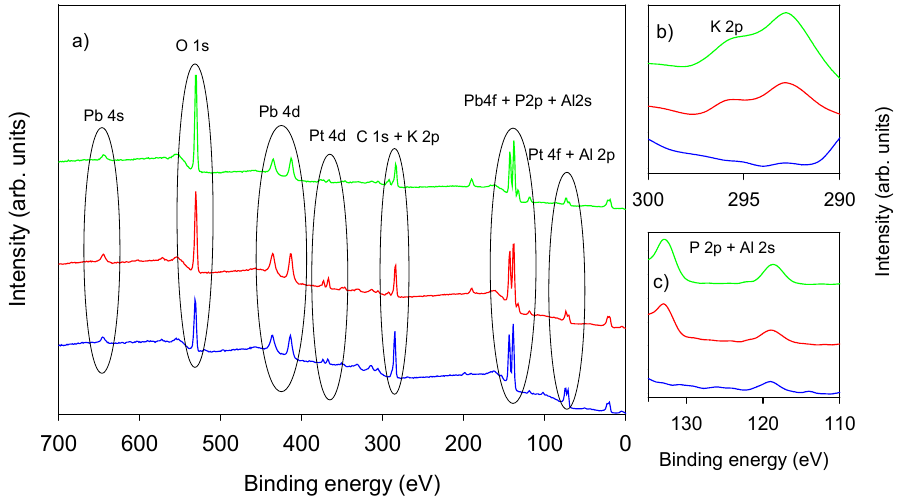
Figure 2. ( a ) XPS survey of untreated Pt SPE (blue trace) and of LIFT treated screen printed electrodes (SPEs) with phosphate buffer 0.1 M (red trace) and 1 M (green trace); ( b ) K 2p region; ( c ) P 2p and Al 2s